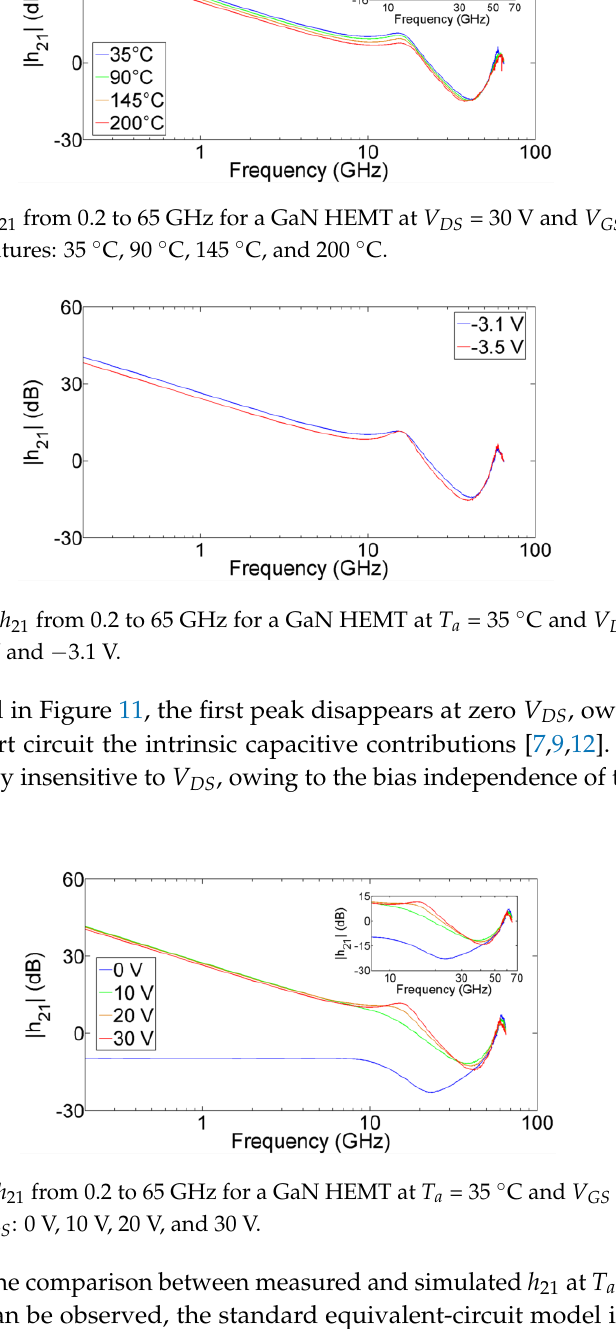
Figure 11. Measured h 21 from 0.2 to 65 GHz for a GaN HEMT at T a = 35 °C and V GS = − 3.1 V for four different values of V DS : 0 V, 10 V, 20 V, and 30 V.